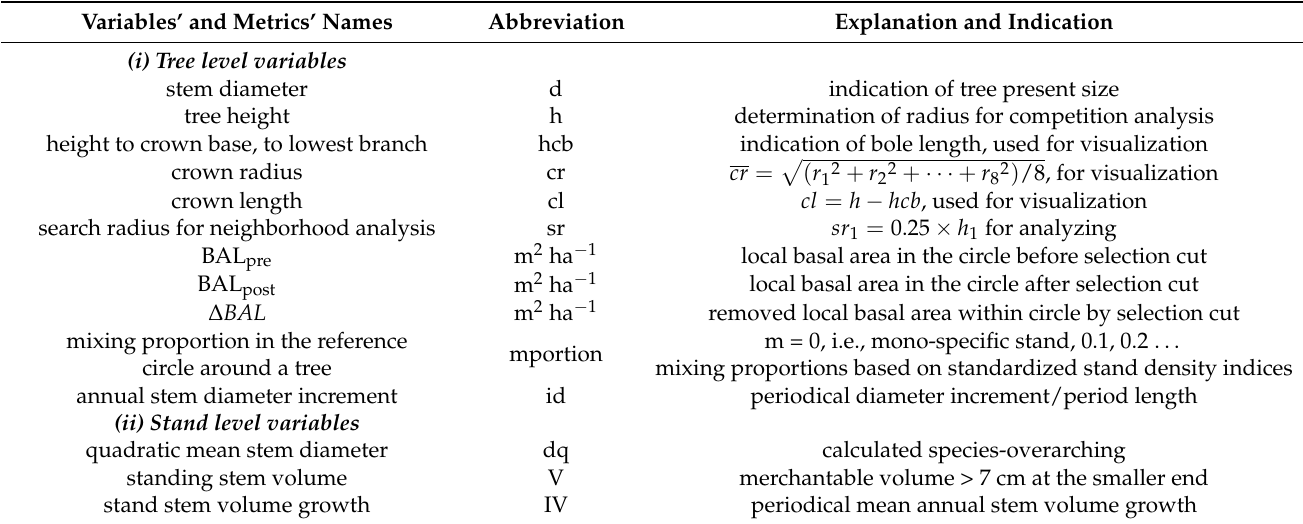
Table 1. Overview of main measurements variables and metrics used in this